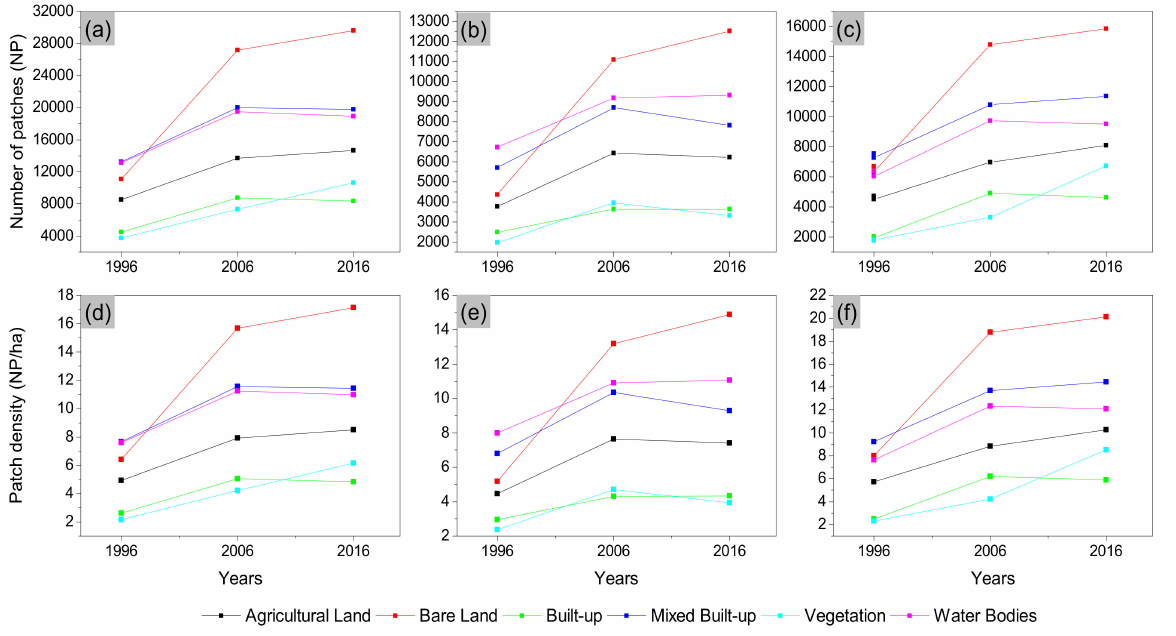
Figure 9. Class level NP over KMA, KMA-urban, and KMA-rural depicted by ( a – c ), in 1996, 2006, and 2016, respectively; and ( d – f ) present the temporal variation in PD of the LULCs over KMA, KMA-urban, and KMA-rural, respectively, in 1996, 2006, and